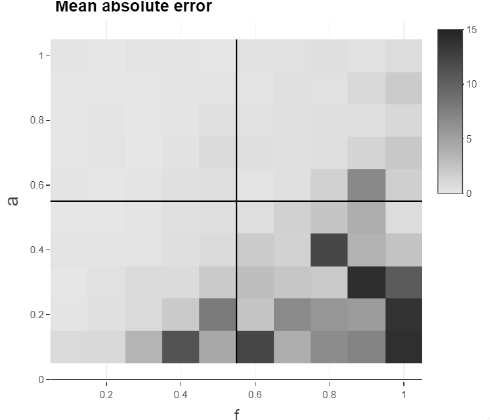
Figure 11. Heatmap of mean absolute error (MAE) for different combinations of a and f